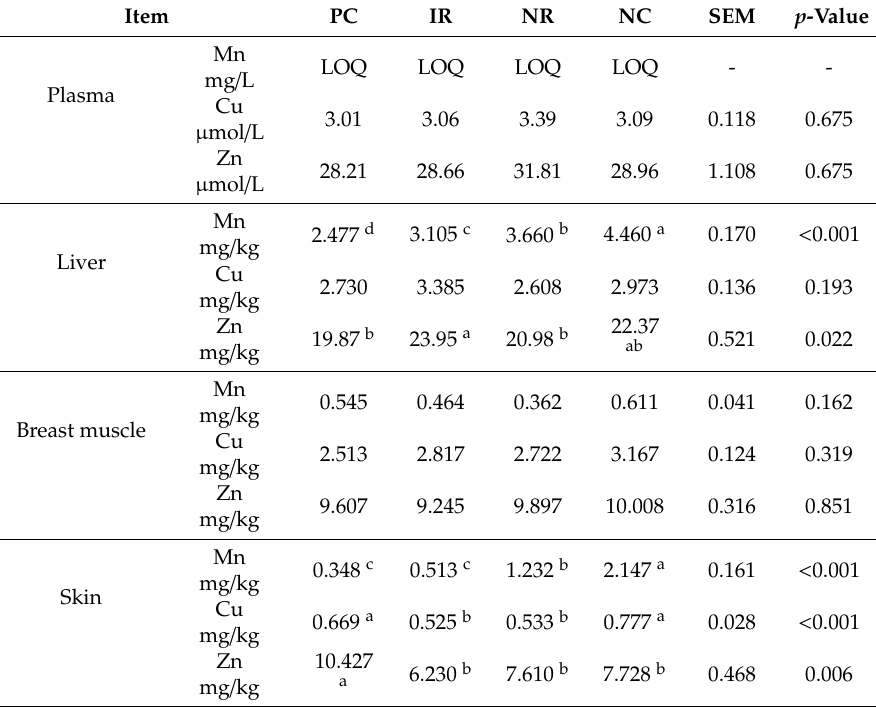
Table 4. Content of Mn, Cu, and Zn in turkey tissues.